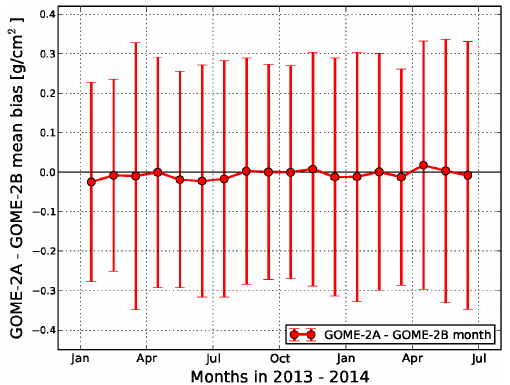
Figure 5. Global monthly mean H 2 O total column bias between GOME-2/MetOp-A and GOME-2/MetOp-B for the period January 2013–June 2014. The large error bars represent the standard devi- ation of the monthly averaged bias and are dominated by natural